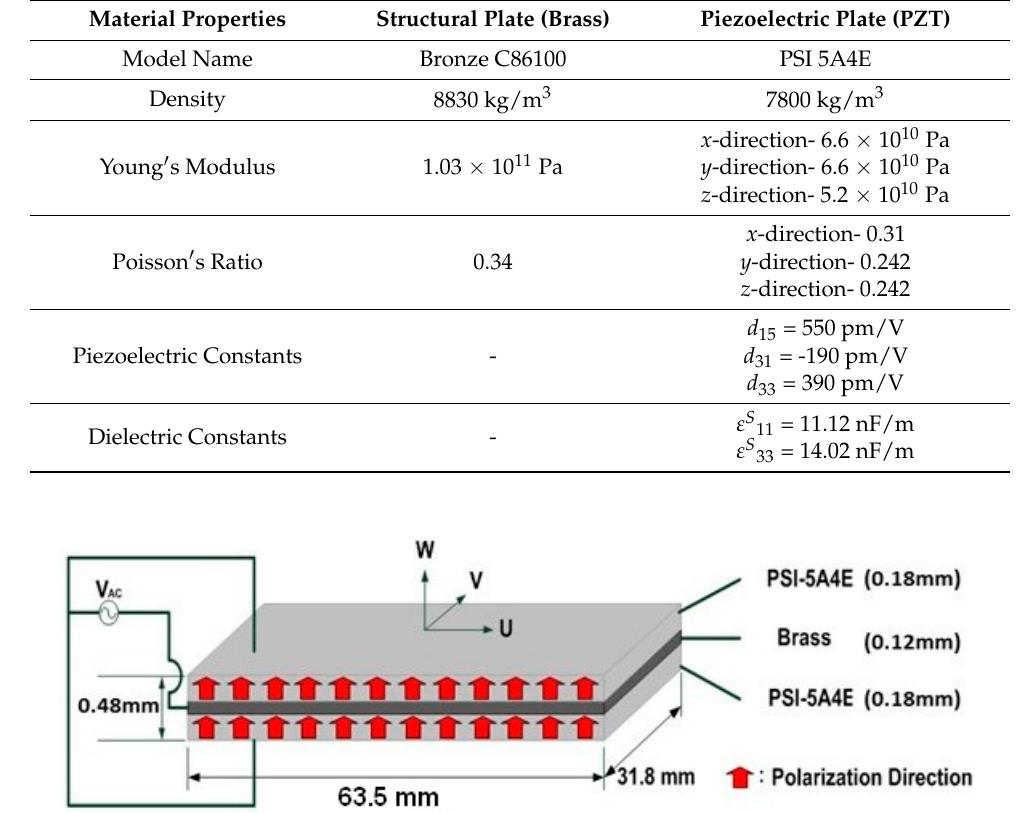
Figure 2. Engineering draft of the ( a ) pump element cover, ( b ) pump element chamber, ( c ) dimensions of inlet and outlet pipes, and ( d ) assembly of proposed pumping element.